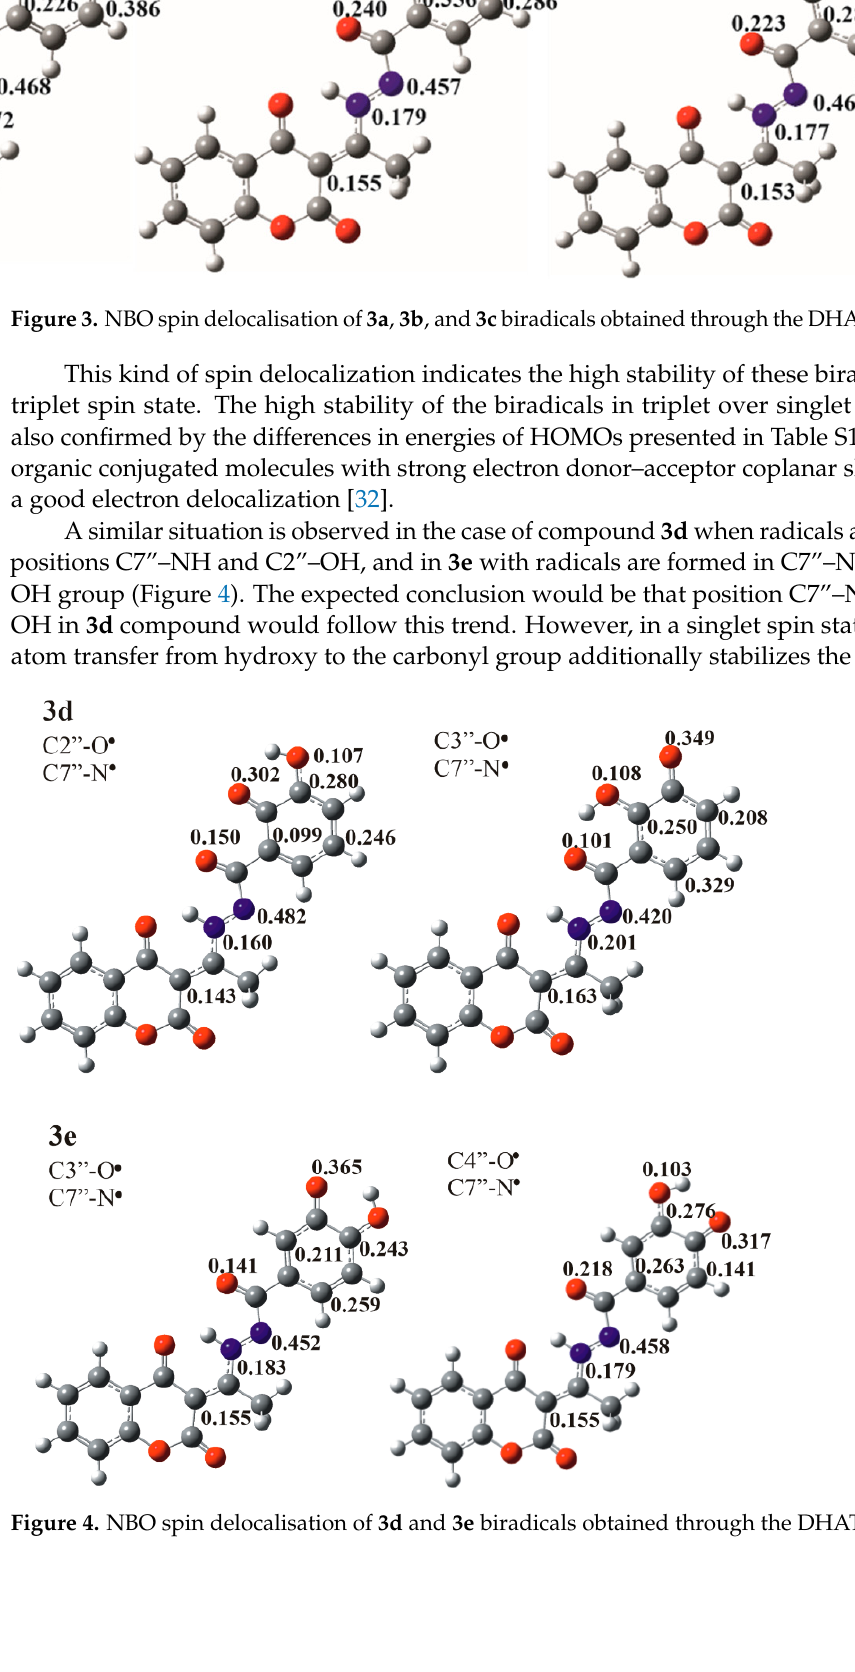
Figure 4. NBO spin delocalisation of 3d and 3e biradicals obtained through the DHAT mechanism.